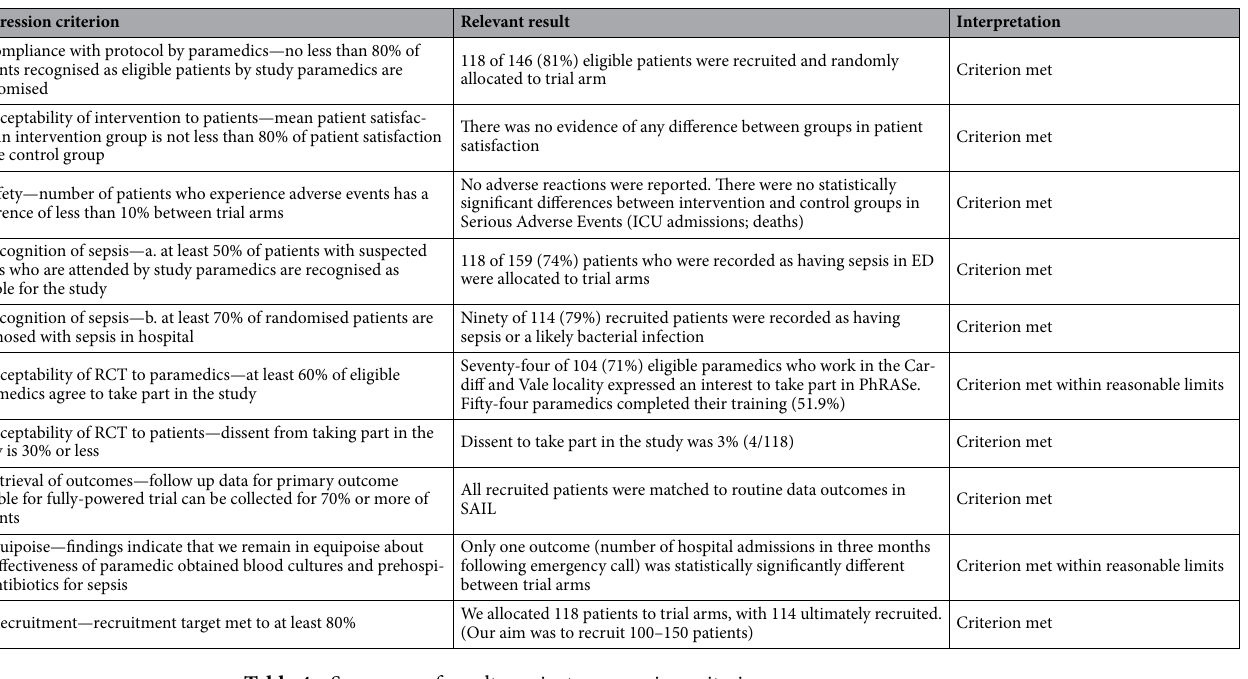
Table 4. Summary of results against progression